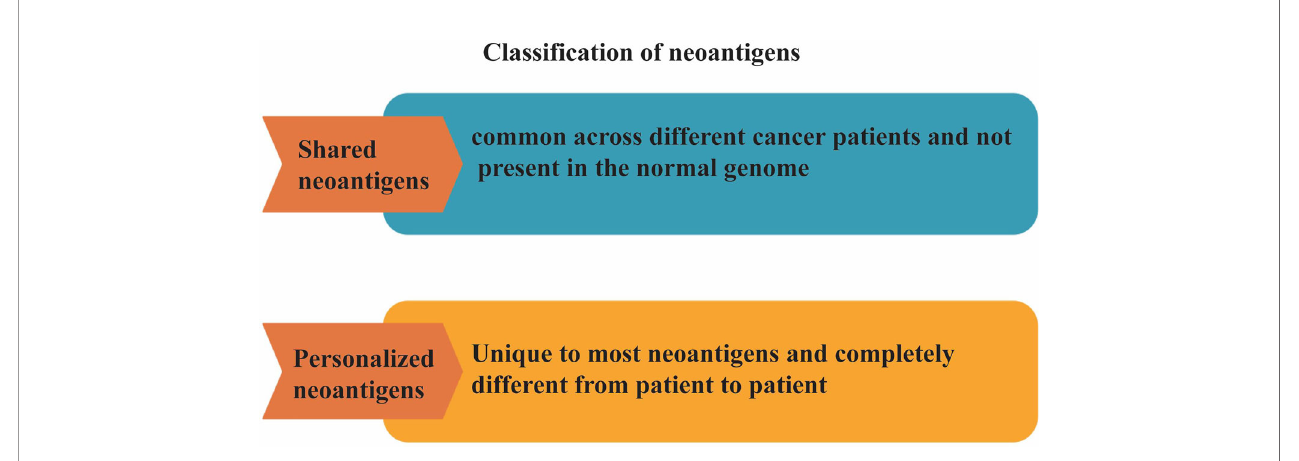
FIGURE 2 | Classi fi cation of neoantigens. Neoantigens can be classi fi ed into two categories: shared neoantigens and personalized neoantigens. Shared neoantigens refer to mutated antigens that are common across different cancer patients and not present in the normal genome. Personalized neoantigens refer to mutated antigens that are unique to most neoantigens and completely different from patient to